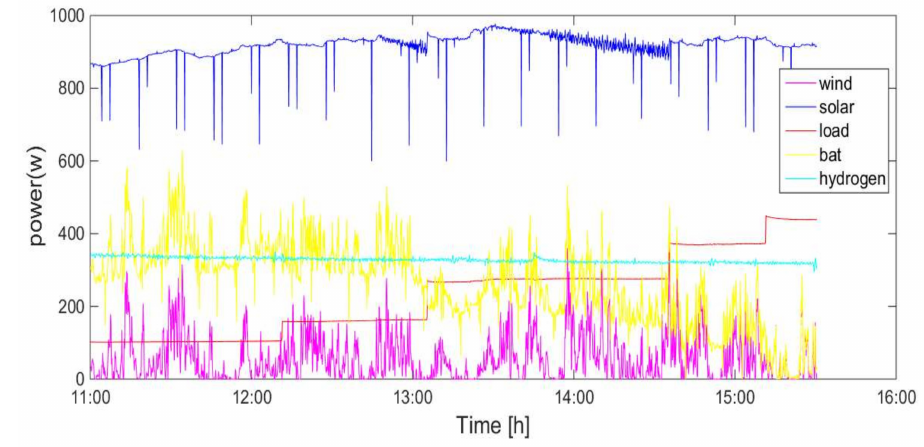
Figure 11. Power curves in scenario 1.